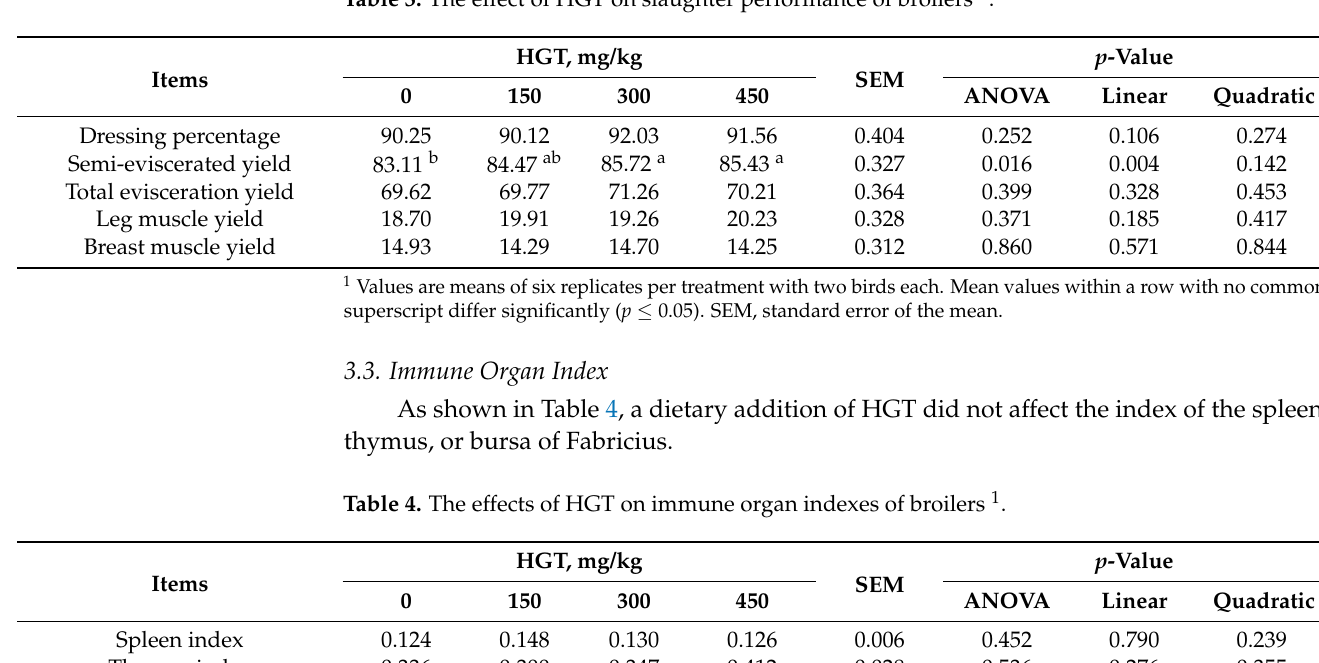
Table 3. The effect of HGT on slaughter performance of broilers 1 .